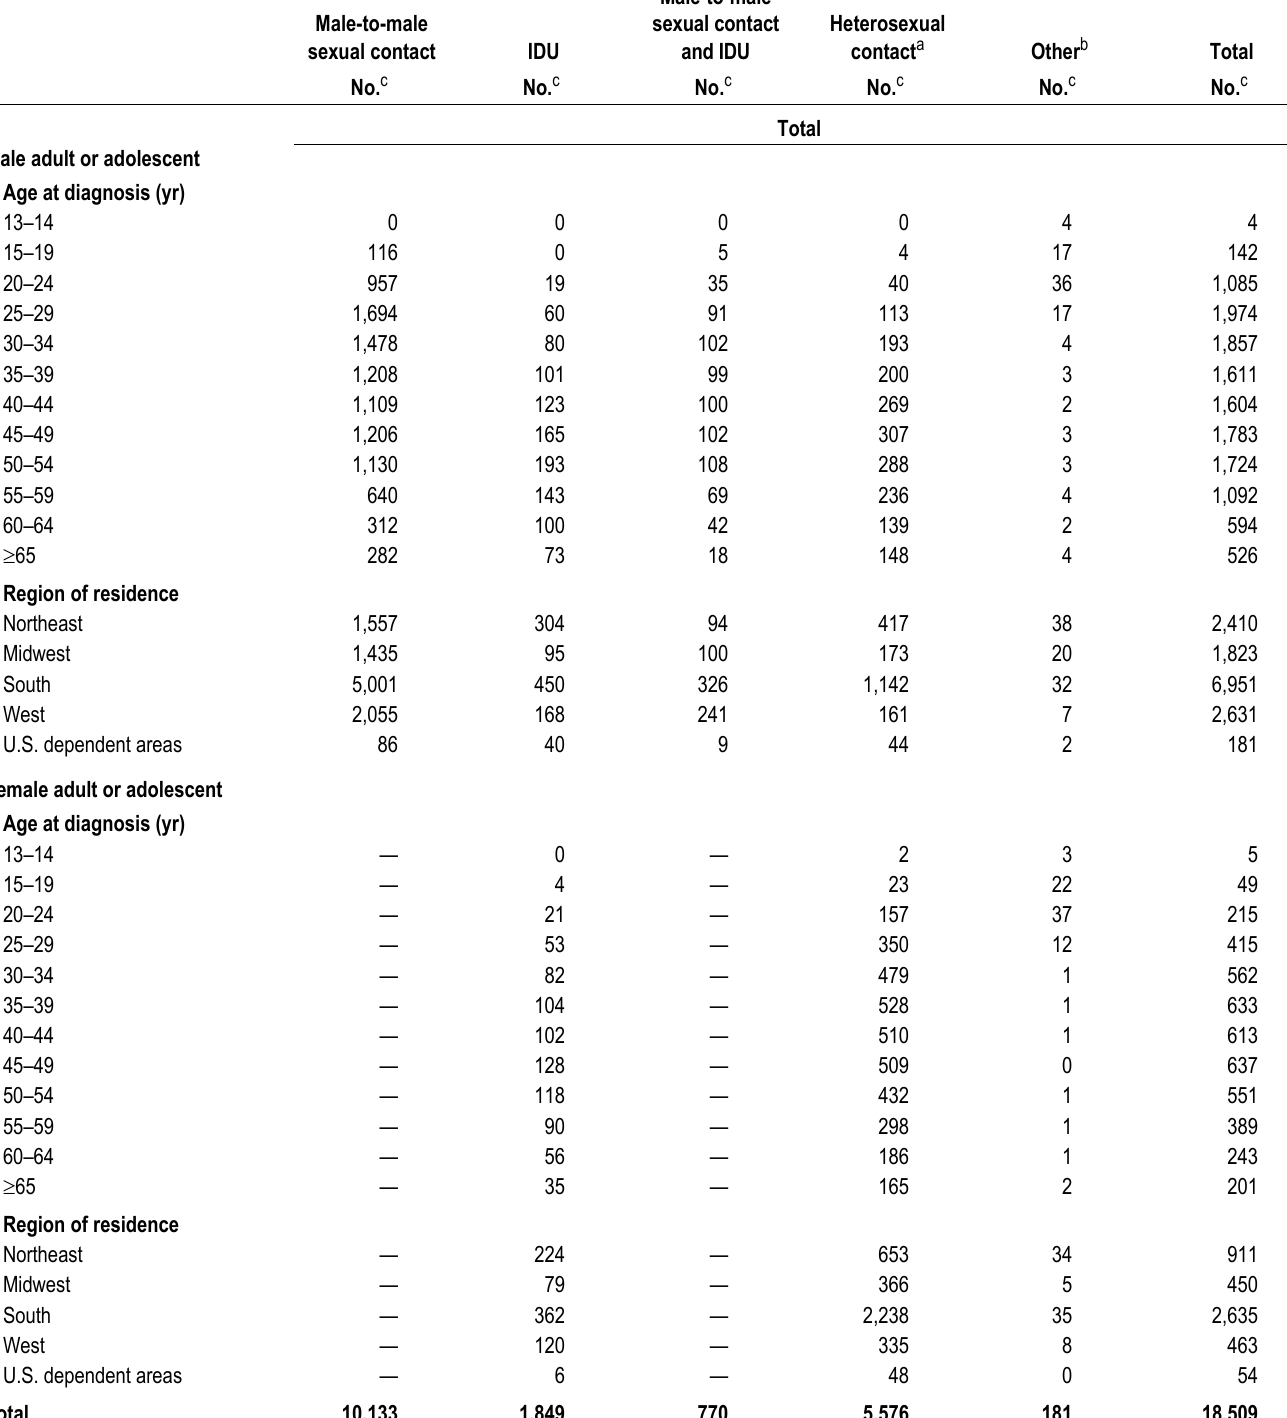
Table 6b. Stage 3 (AIDS), by transmission category, race/ethnicity, and selected characteristics, 2015—United States and 6 dependent areas